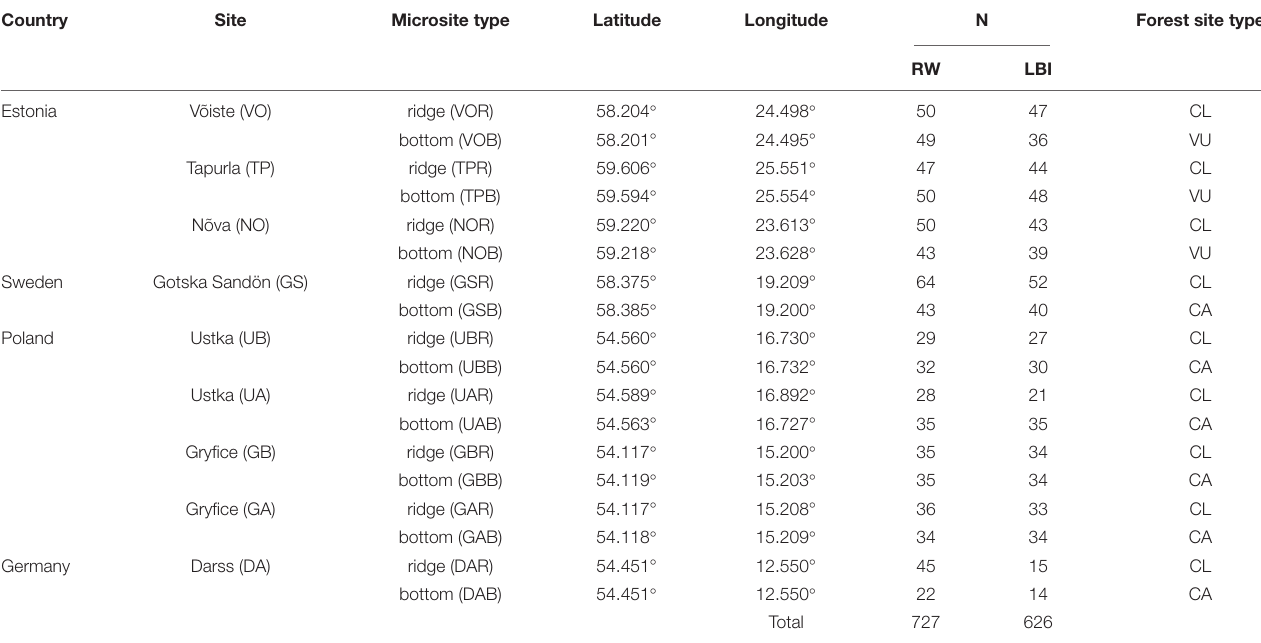
TABLE 1 | Description of the study sites (the last letter in the code of microsite type refers to the ridge (R) and bottom (B) of the dune), number of analyzed trees (N: RW – ring-width, LBI – latewood blue intensity) and forest site type (CL - Cladonia , CA – Calluna , VU – Vaccinum uliginosum ). Country Site Microsite type Latitude